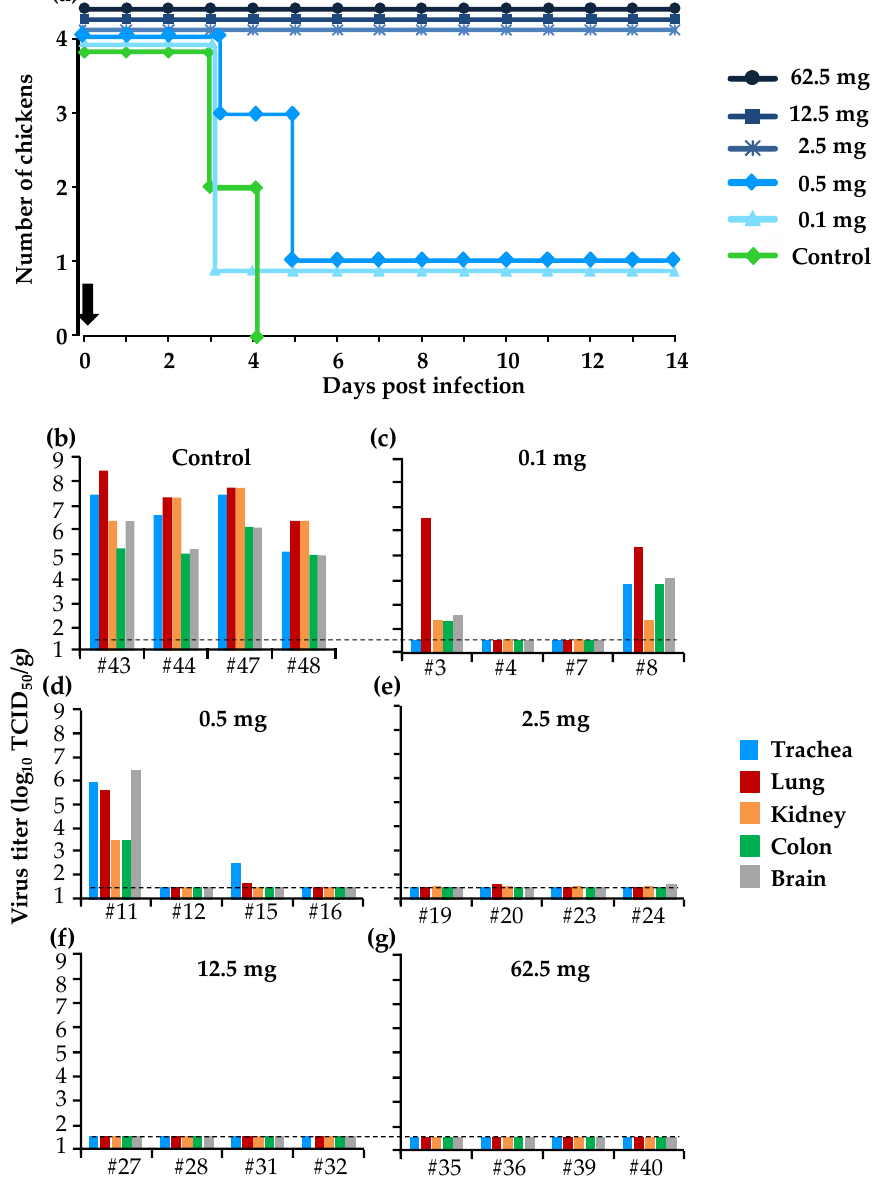
Figure 3. E ff ects of the simultaneous treatment with a single dose of BXM in chickens. Eight chickens per treatment group were infected with 10 CLD 50 / 100 µ L (5.3 log 10 EID 50 ) of the HPAIV, A / BS / Akita / 1 / 16, and they were immediately treated with di ff erent doses of BXM or untreated to serve as the control. ( a ) Survival of half the birds in each group was monitored until 14 dpi; the vertical black arrow indicates the treatment schedule. ( b – g ) Viral recovery from organs collected at 3 dpi from four chickens was assessed in MDCK cells; the black dotted line indicates the detection limit (1.5 log 10 TCID 50 /g).